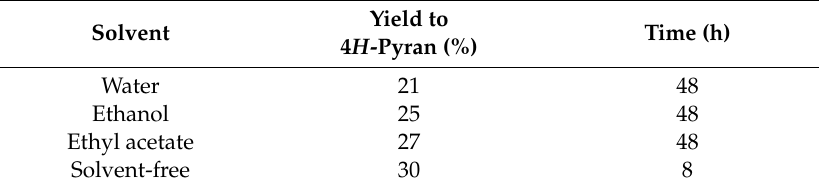
Table 3. E ff ect of the solvent.